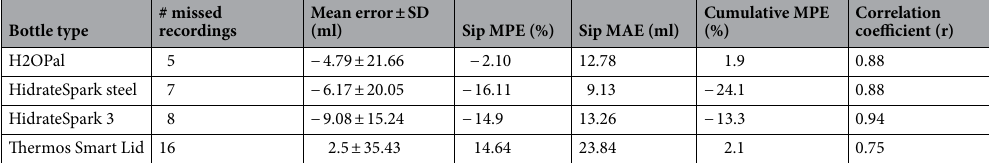
Table 1. Performance data for each commercial